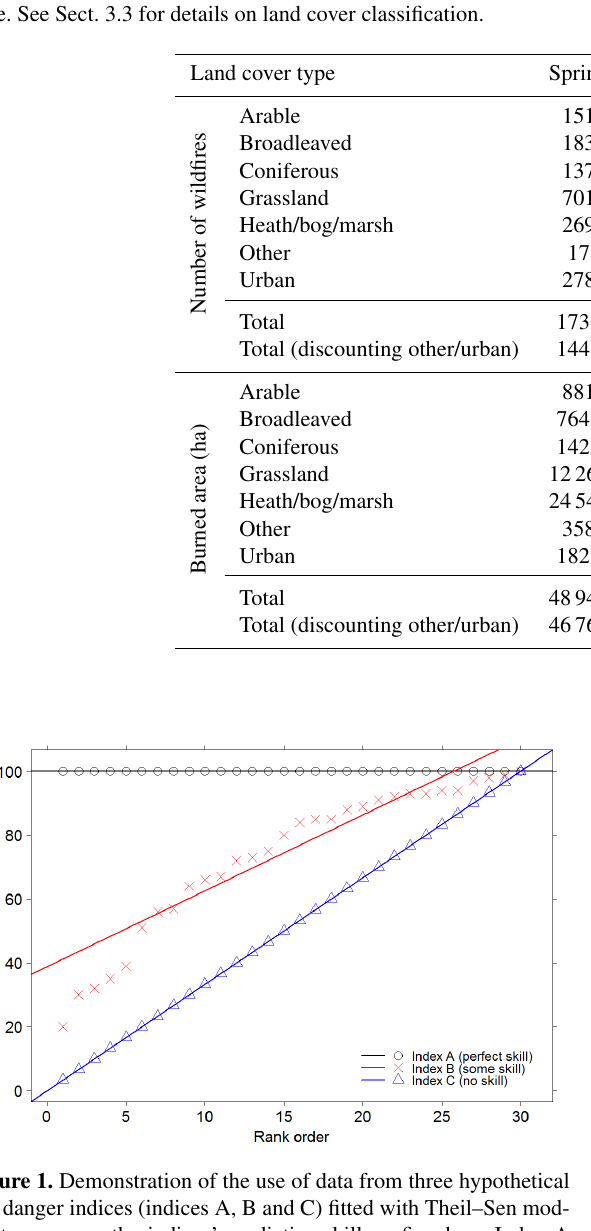
Table 1. Number of wildfire events and burned area data reported in Great Britain between January 2010 and December 2012 from the filtered UK Fire and Rescue Service Incident Recording System (IRS) data set developed herein, disaggregated by season and land cover type. See Sect. 3.3 for details on land cover classification.